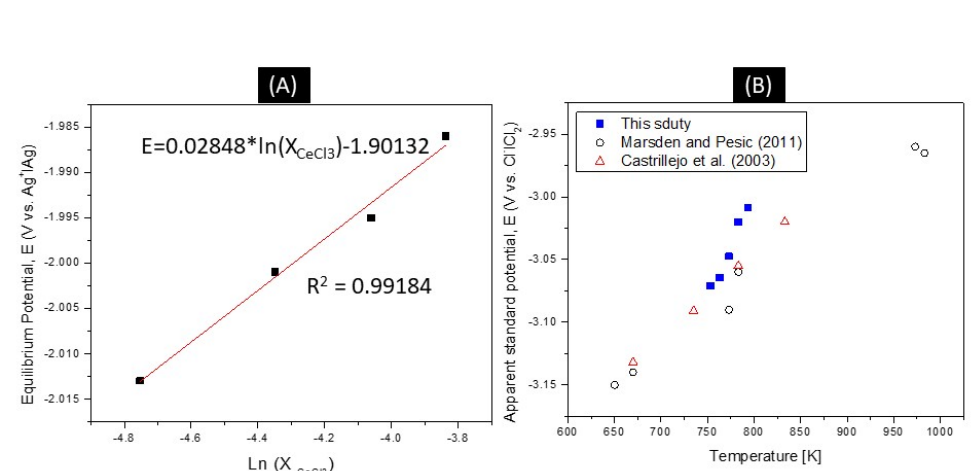
Figure 8. ( A ) − 1.901 V apparent standard potential vs. the 5 mol% Ag +| Ag reference scale at 773 K. Figure 8. ( A ) −1.901 V apparent standard potential vs. the 5 mol% Ag+ │ Ag reference scale at 773K. ( B ) Comparison of values from literature [7,14]. ( B ) Comparison of values from literature [7,14].